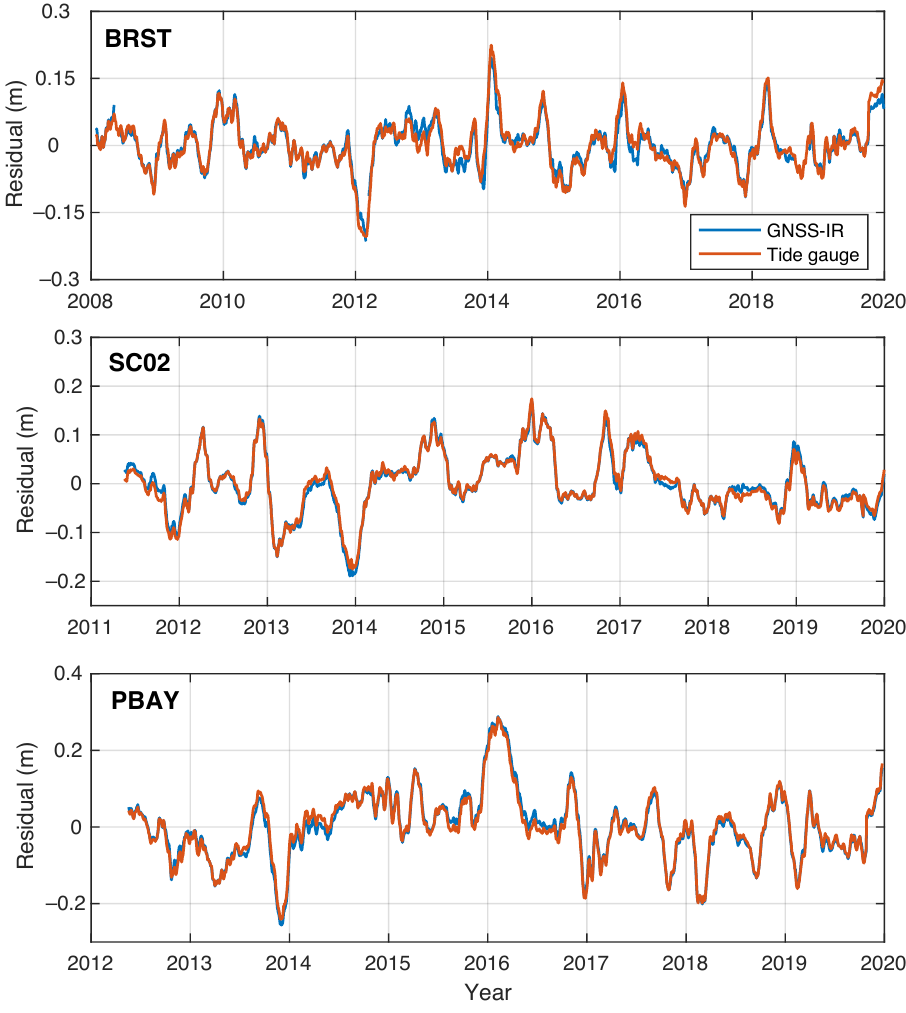
Figure A3. De-seasoned and de-trended time series of relative sea levels from GNSS-IR and tide